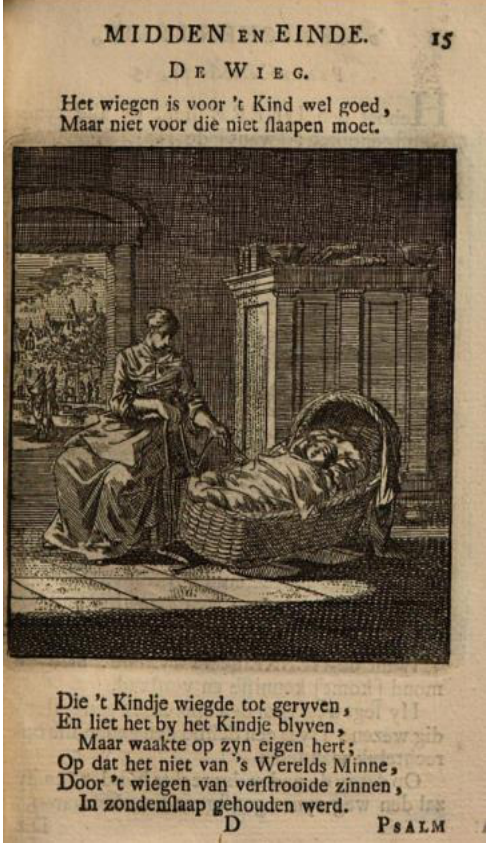
Figure 6. Jan Luyken, “ De Wieg ,” Des Menschen, Begin, Midden en Einde.